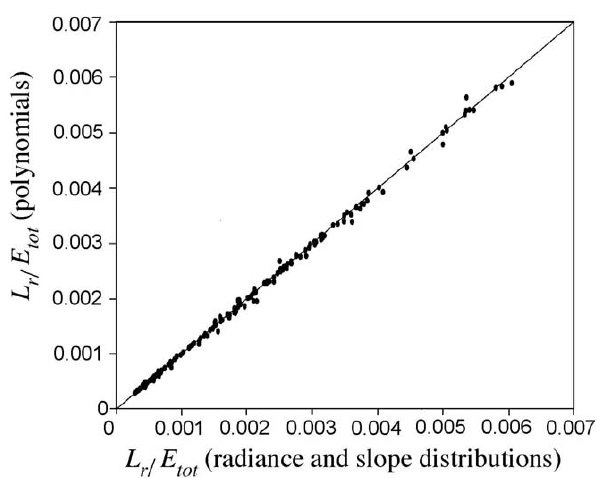
Fig. 8. The ratio L r /E tot obtained from the polynomials of Ta- ble 5 as a function of the same ratio calculated from the radiance and slope distributions, at the wavelengths 405, 450, 520, 550 and 650nm, and at the wind speeds 0, 5 and 10ms − 1 . Fig ure 8. The ratio L r /E tot obtained from the polynomials of Table 5 as a function of the same than by the polynomials of Table 5, thus disregarding the so- ratio calculated from the radiance and slope distributions, at the wavelengths 405, 450, 520, lar zenith angle, the RMS value of the errors for the estimated total reflectance L r /E tot will increase only slightly, from 2.0– 550 and 650 nm, and at the wind speeds 0, 5 and 10 m s -1 . 6.7–8.1 to 2.3–7.0–10.6 in units of 10 − 5 for the wind speeds 0–5–10 m s − 1 , respectively, and as we see the error will still be ≤ 0.0001 at all wind speeds ≤ 10 m s − 1 . If we also disre- gard the influence of wavelength on the ratio L r , sky / L (0 ◦ ) by using the mean values of L r , sky / L (0 ◦ ) from Table 1, the RMS value of the estimated L r /E tot remains practically the same as in the last